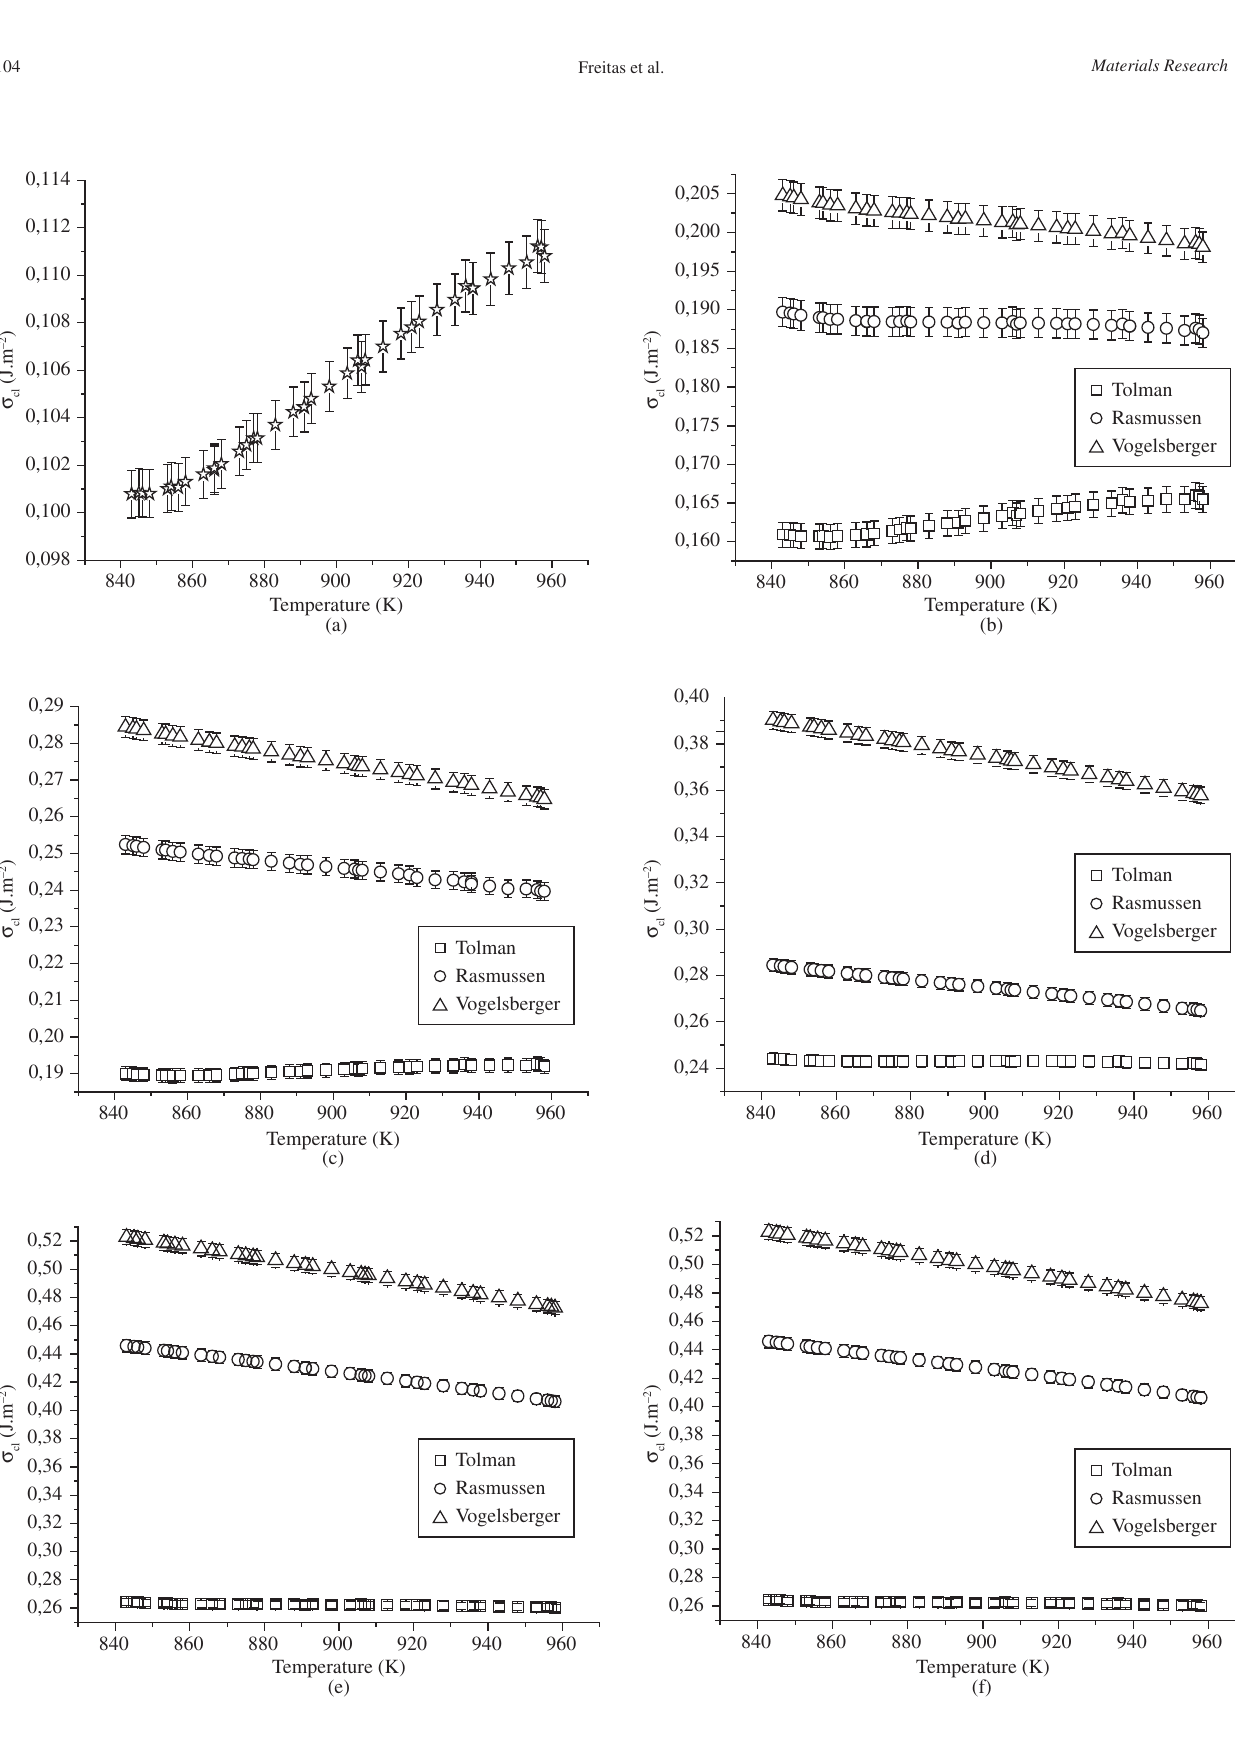
Figure 3. Crystal-melt surface energy as a function of the temperature calculated for a N ( □ ), Rasmussen ( ○ ) and Vogelsberger (  ). The δ values used were: a) 0; b) 2.95 x 10 –10 m; c) 4.5 x 10 –10 m; d) 7,5 x 10 –10 m; e) 8.65 x 10 –10 m; f) 10 –9 m. For were obtained for all decoupling equations. These values are indicated as (  δ = 0, the same values of σ cl